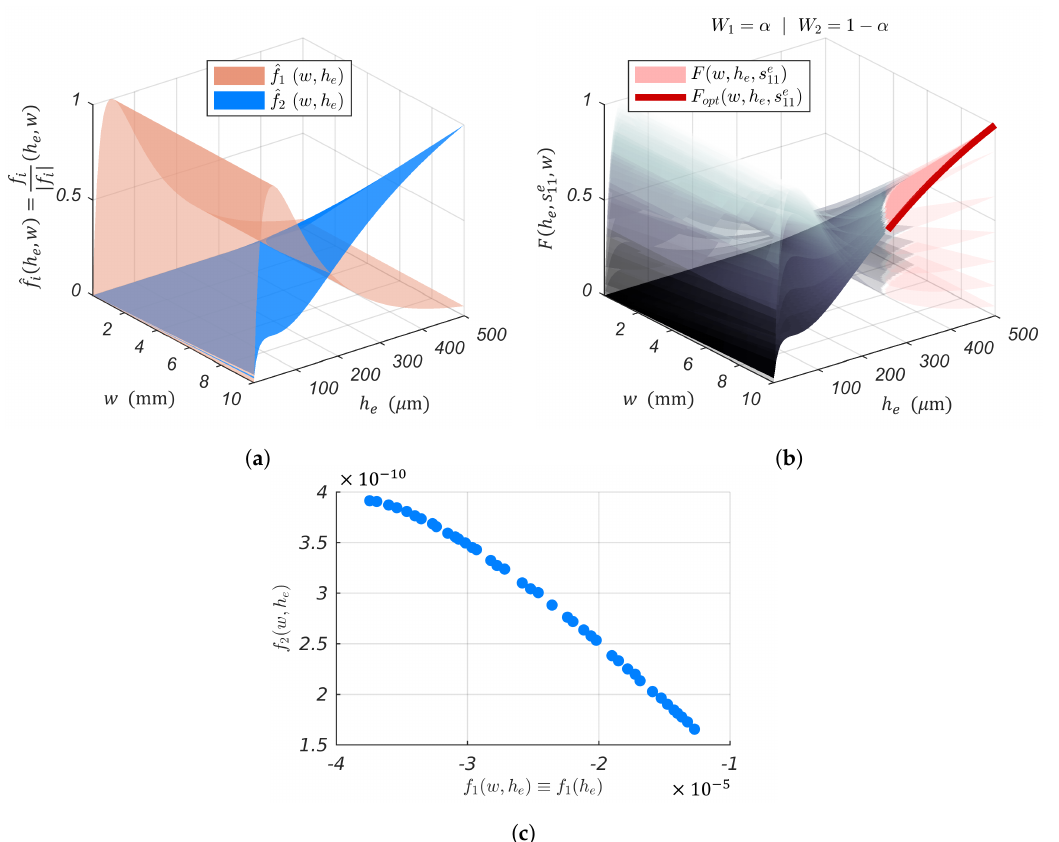
Figure 6. Trade-off between the actuator and sensor objectives, f 1 and f 2 , respectively. The piezoelectric actuation f 1 is independent of the cantilever width. ( a ) Overlapping of the PEA’s actuation and sensing behaviors. ( b ) Evolution of the SSA’s geometrical optimal configuration as a function of the ) describes combinations of h e and w for Ag as the elastic layer that weighting factor W i . F ( w , h e , s e 11 ) represent the optimality of F ( w , h e , s e ) . satisfy the blocking force geometric constraint. F opt ( w , h e , s e 11 11 ( c ) Pareto